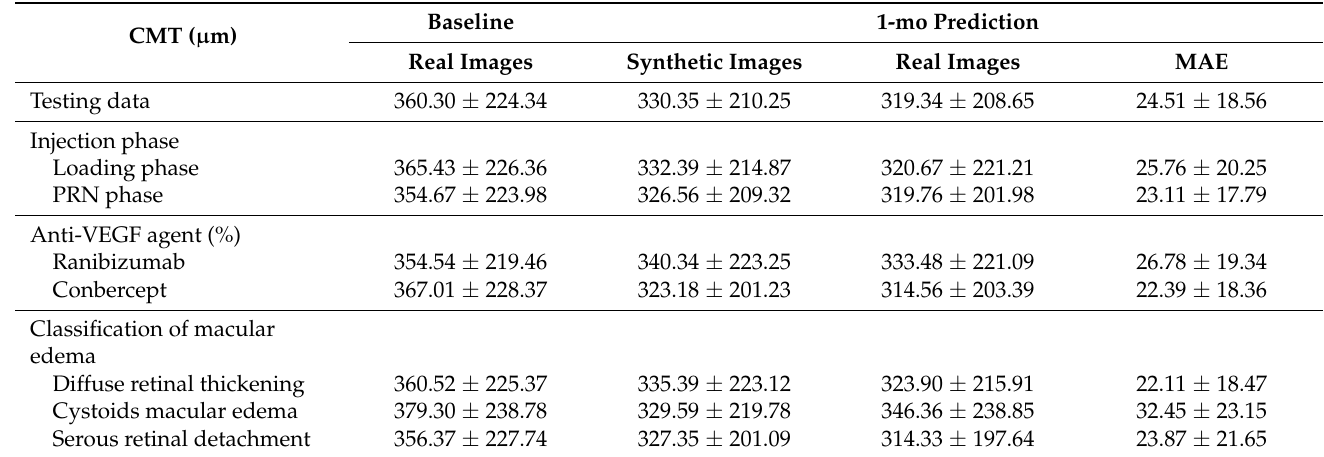
Figure 6. Illustration of the synthetic OCT images with different types of macular edema. The images in the right column are synthetic post-therapeutic images by the pix2pixHD. The images in the middle column are the actual image. Table 3. Accuracy of the Synthetic Post-therapeutic OCT Images of DME in the Evaluating